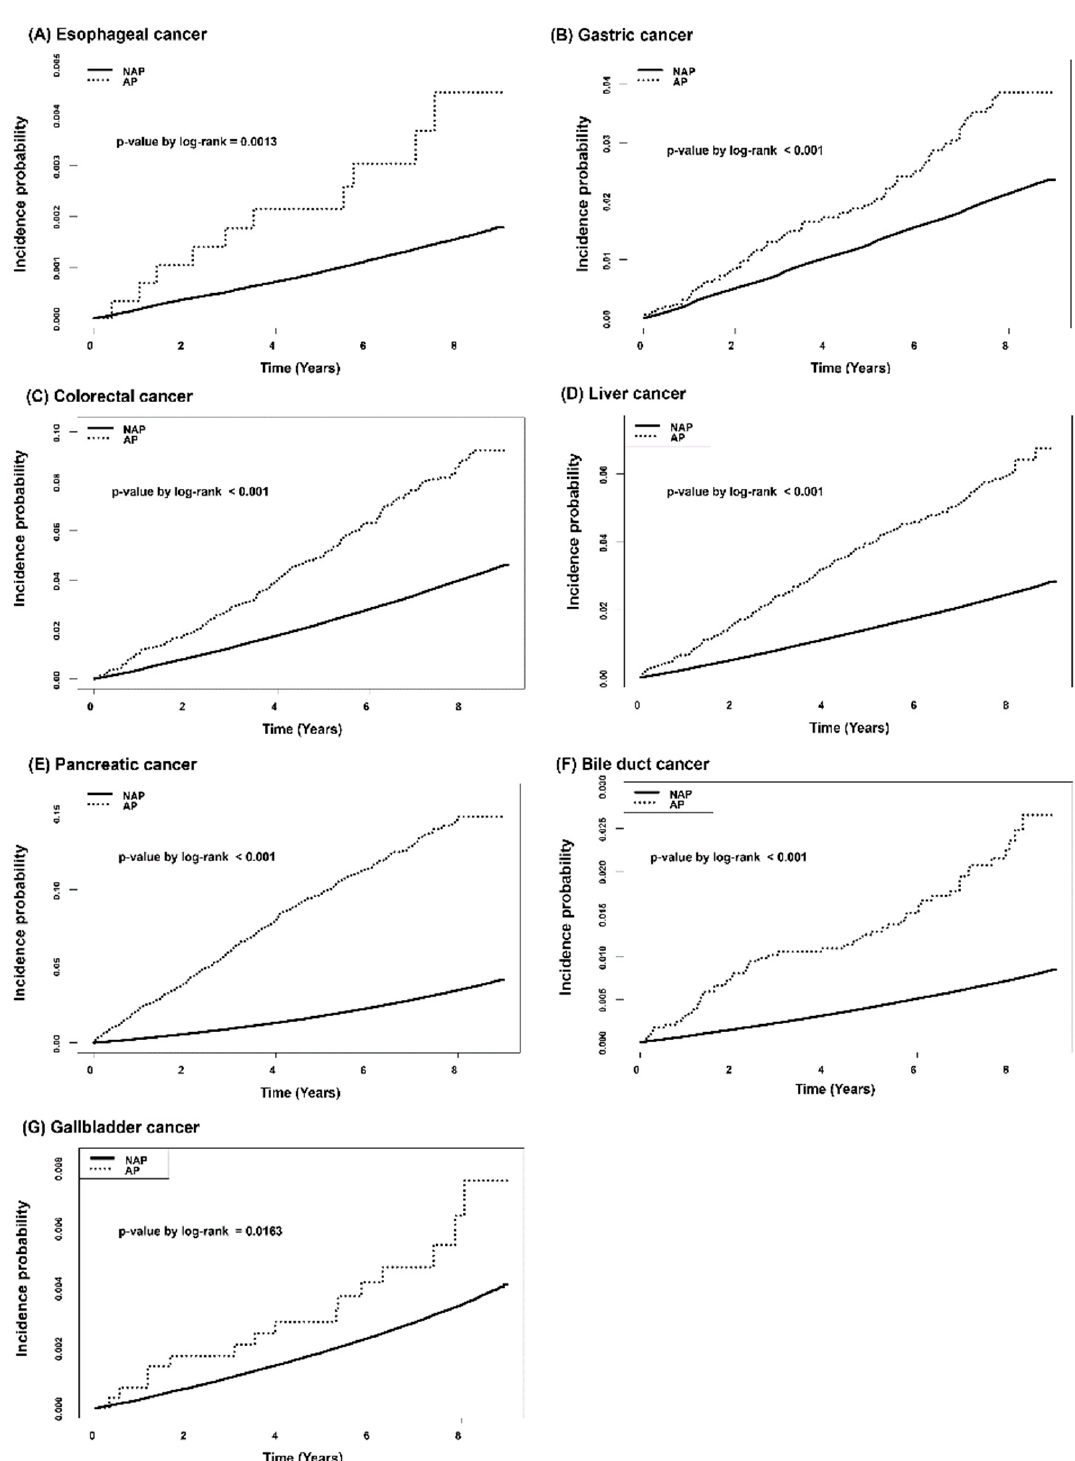
Figure 2. Kaplan-Meier curves for cumulative incidence probability of gastrointestinal cancer according to history of acute pancreatitis: ( A ) Esophageal cancer, ( B ) Gastric cancer, ( C ) Colorectal cancer, ( D ) Liver cancer, ( E ) Pancreatic cancer, ( F ) Bile duct cancer, ( G ) Gallbladder cancer.